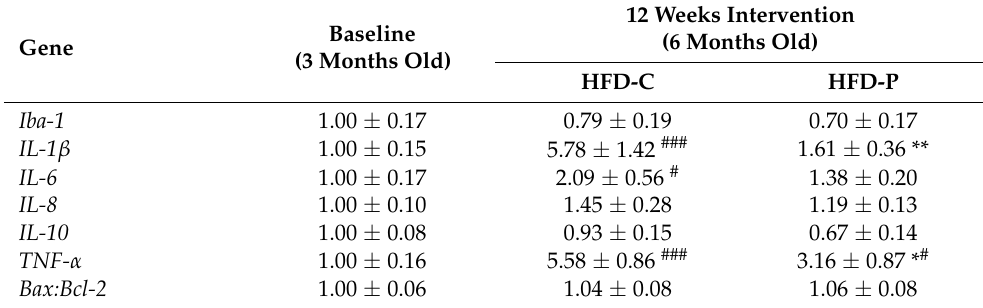
Figure 4. The impact of 12 weeks supplementation with Lab4P on neuronal spine density in the hippocampus of 3xTg-AD mice on a high fat diet (Study B). ( i ) Representative DiOlistic images showing thin, stubby and mushroom dendrites in the hippocampus and changes from baseline (BLB) in ( ii ) total or ( iii ) stubby, mushroom and thin spine densities in the hippocampus of 3xTg-AD mice receiving HFD alone (HFD-C) or HFD plus Lab4P (HFD-P) for 12 weeks. Data are expressed as mean ± standard error of the mean (SEM). Mouse numbers for each data point/group were 4 mice (Day 0) and 4 mice (12 weeks). Values of p were determined using one-way ANOVA with Tukey’s post hoc analysis or Brown–Forsythe ANOVA with Dunnett’s T3 post hoc analysis where ** p < 0.01 or *** p < 0.001 versus the control or # p < 0.05, ## p < 0.01 or ### p < 0.001 versus the baseline. Scale bar 10 μ m. Table 2. Fold change in mRNA expression in the hippocampus of HFD-fed 3xTg-AD mice (Study B). Shown are the changes from baseline in mRNA expression in the hippocampus of 3xTg-AD mice receiving HFD alone (HFD-C) or HFD plus Lab4P (HFD-P) for 12 weeks (Study B). mRNA expression is presented as a mean fold change ± standard error of the mean (SEM) of five mice compared to baseline that has been arbitrarily set as 1. Values of p were determined using one-way ANOVA with Tukey’s post hoc analysis where * p < 0.05, ** p < 0.01 versus the control or # p < 0.05 or ### p < 0.001 versus baseline. Abbreviations: Iba-1 , ionized calcium-binding adaptor protein-1; IL , interleukin; TNF- α , tumour necrosis factor- α ; Bcl-2 , B-cell lymphoma 2 gene; Bax , Bcl-2 -associated X apoptosis